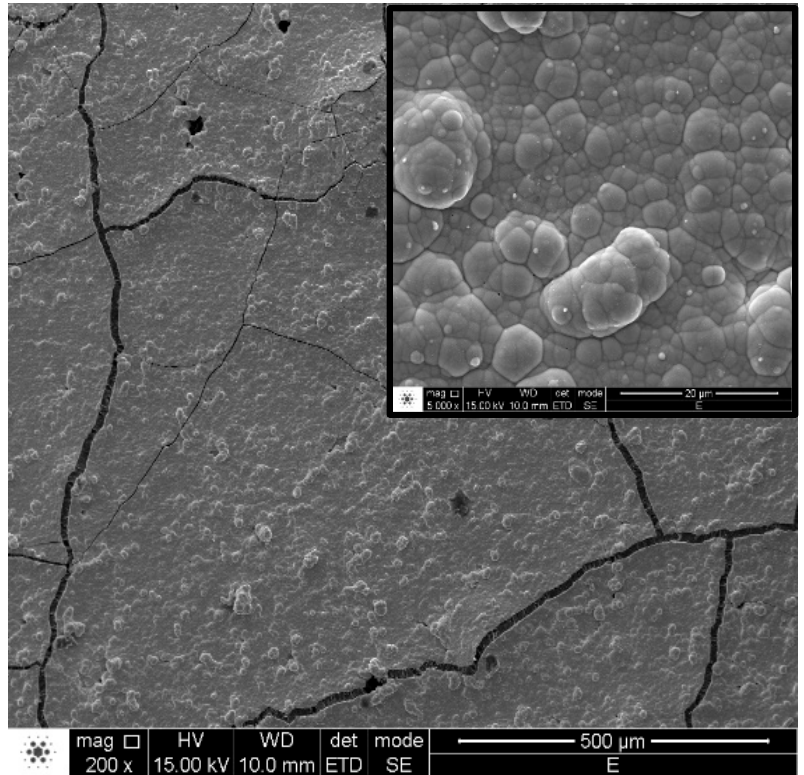
Figure 6. SEM micrographs of PHNBR after electroless Ni-P plating, with an inset at 5000× magnification.